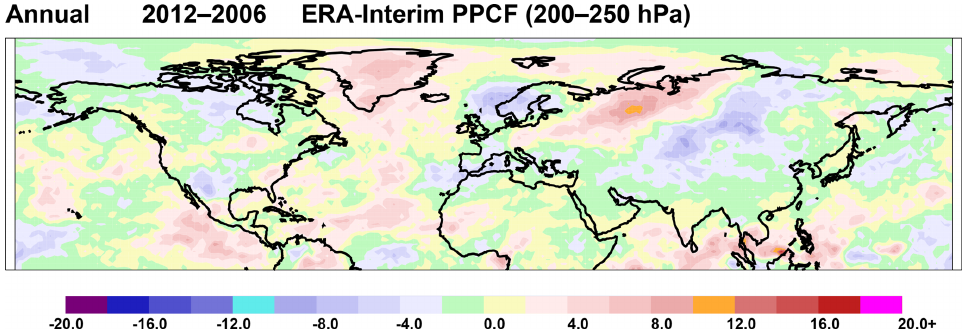
Figure 6. Difference (2012 minus 2006) in the potential persistent contrail frequency (in percent) computed between 200 and 250hPa from ERA-Interim reanalysis